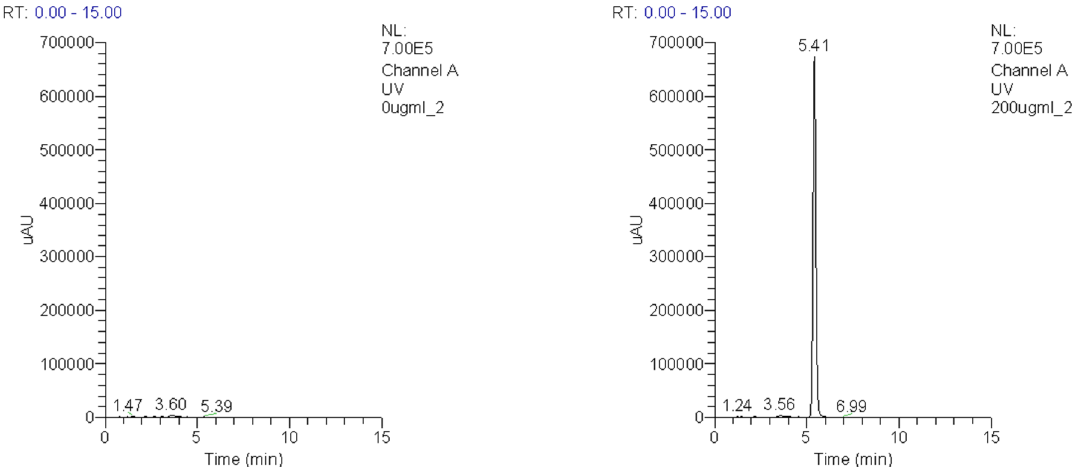
Figure 2. HPLC chromatograms of a blank sample (left) and a sample receiving 200 μg/mL IDD-1040 (right).